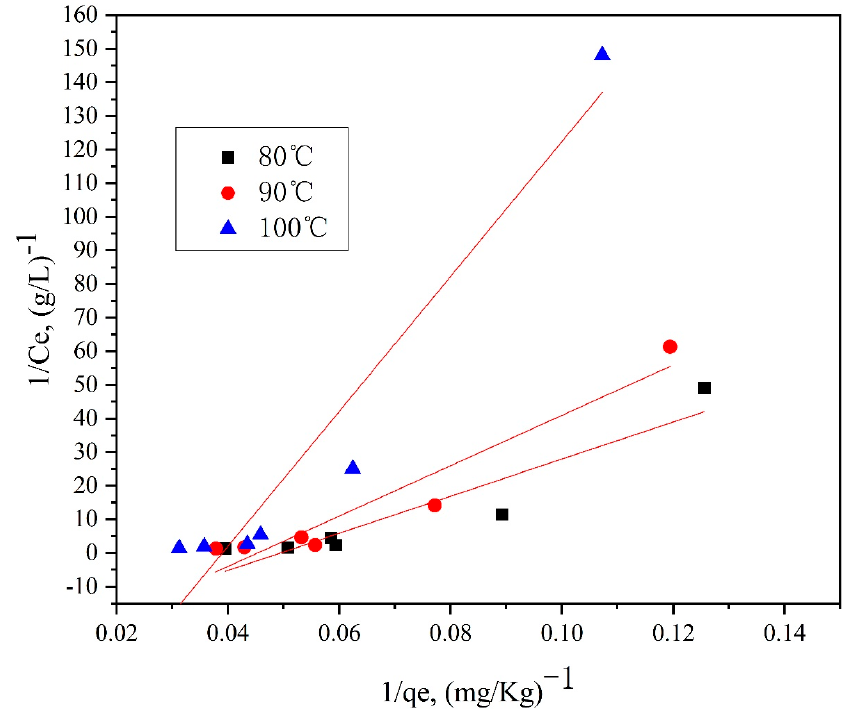
Figure 14. Langmuir model of ordinary spandex dyed with neutral red G.